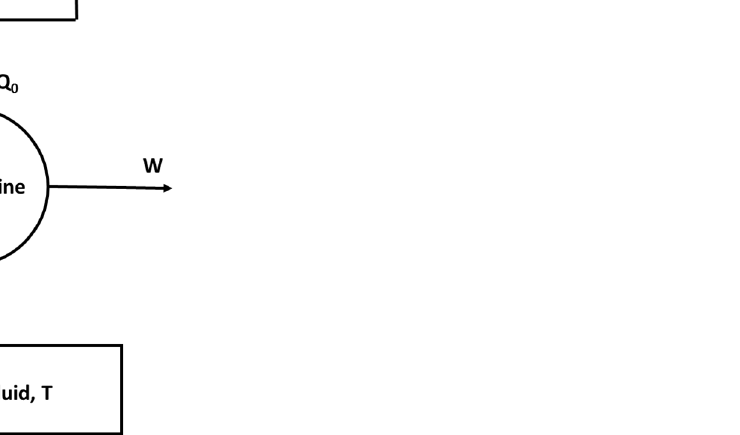
Figure 10. A cyclic heat engine operating with two heat sources: the environment and a cryogenic